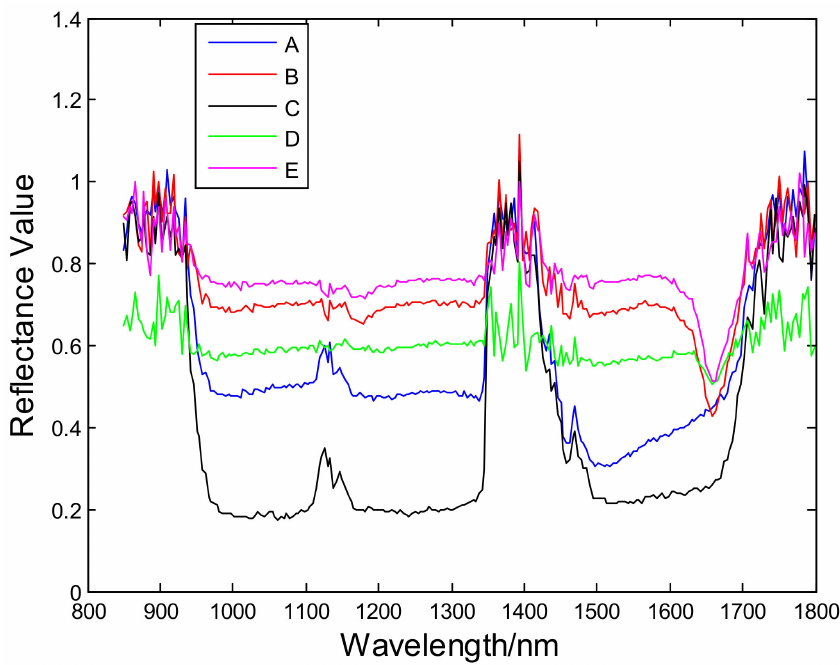
Figure 6. Spectral reflectance of A, B, C, D, E in near-infrared